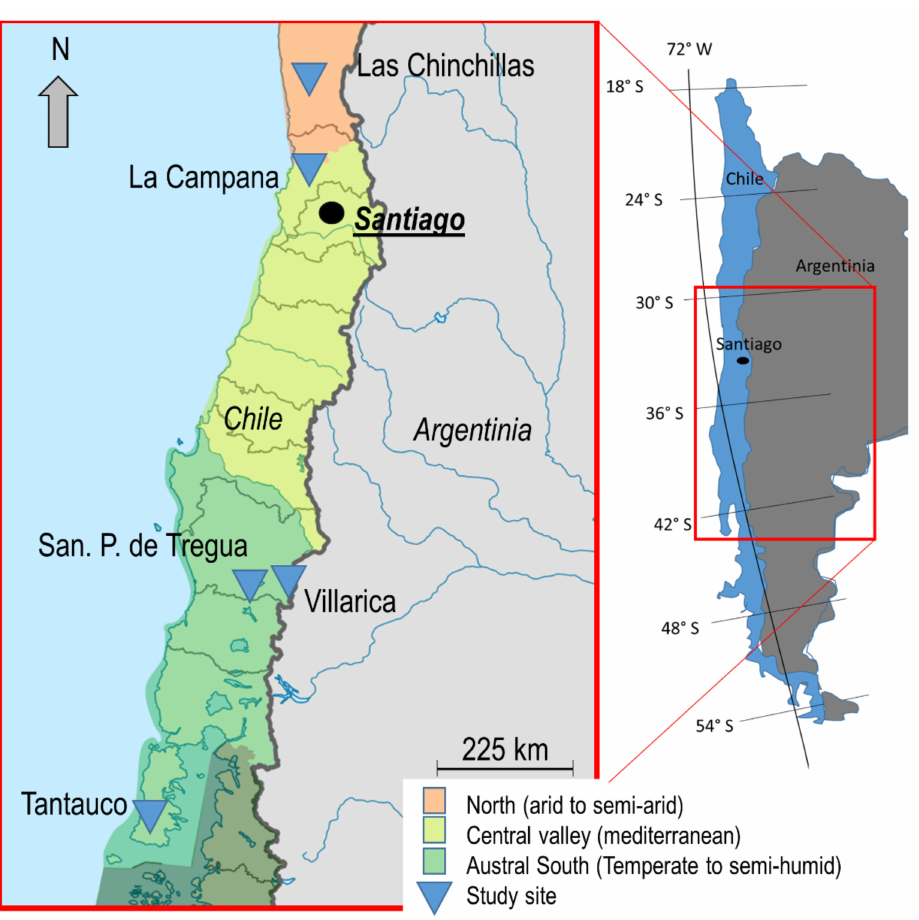
Figure 1. Map of the five study site locations in